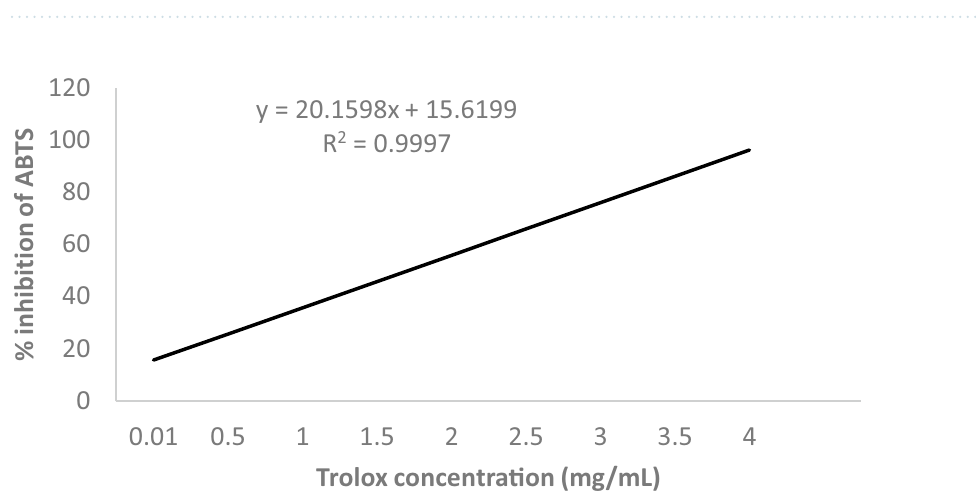
Figure 8. Calibration curve of the % inhibition of DPPH by Trolox versus the applied concentration range.